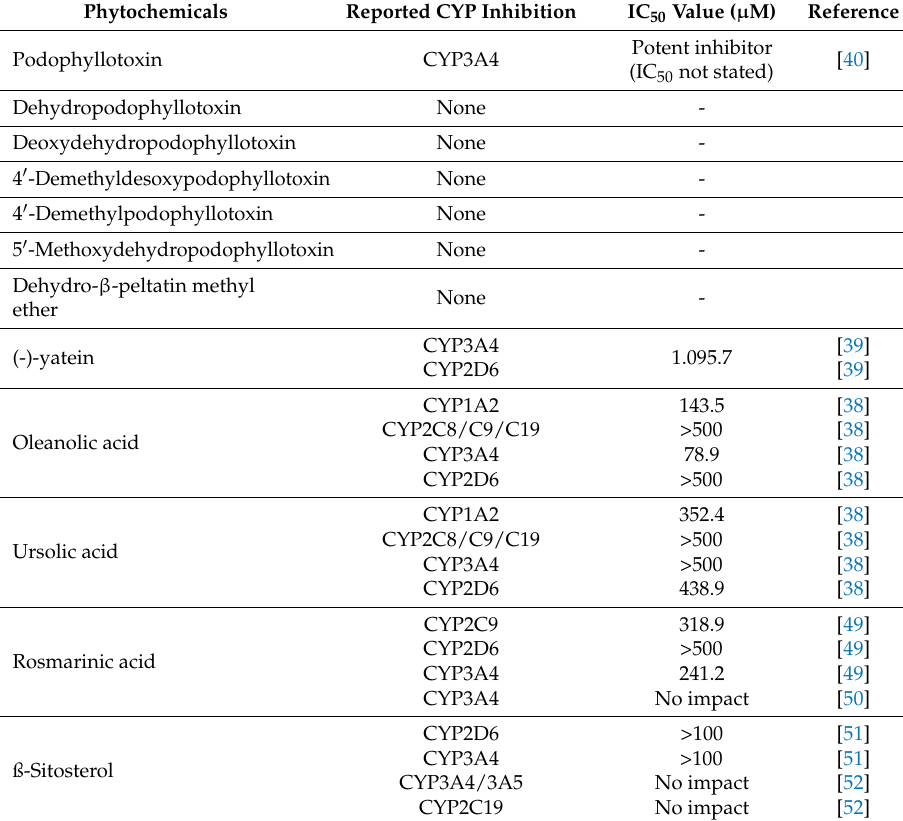
Table 3. Review of published CYP inhibition research for key